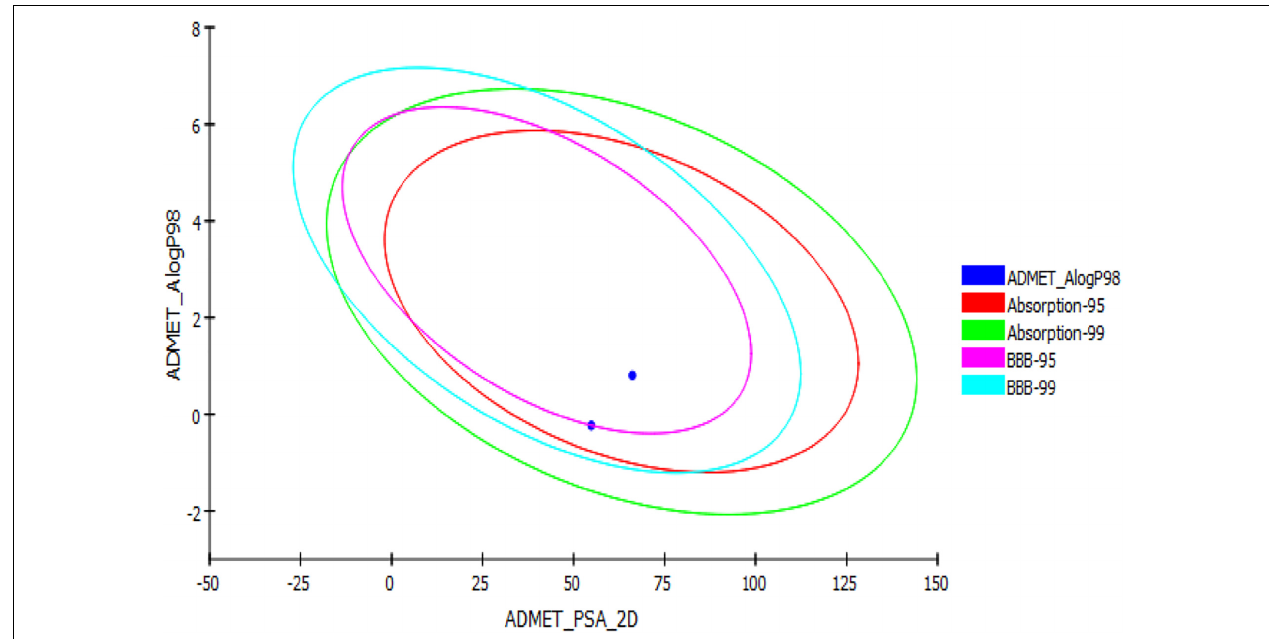
FIGURE 3 | ADMET plot for glitazones: Plot indicates that both the glitazones being inside the ellipses’ boundaries possess ideal ADMET properties.